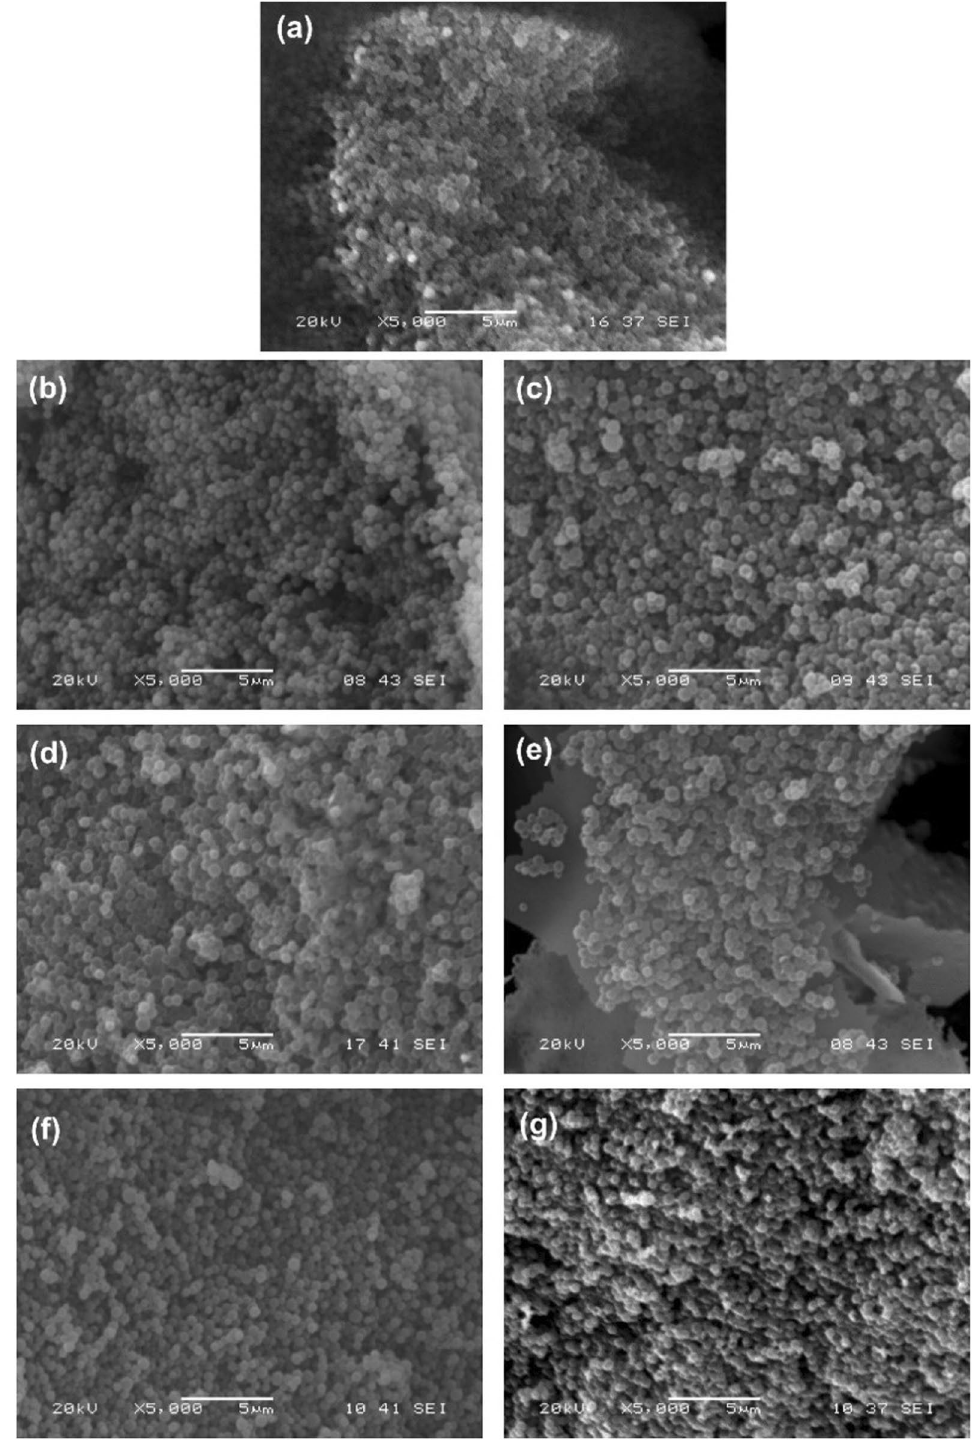
Figure 6. SEM images of the samples. ( a ) pure carbon spheres, ( b ) C-TiO 2 -80C, ( c ) H-TiO 2 -80C, ( d ) C-TiO 2 - 250C, ( e )